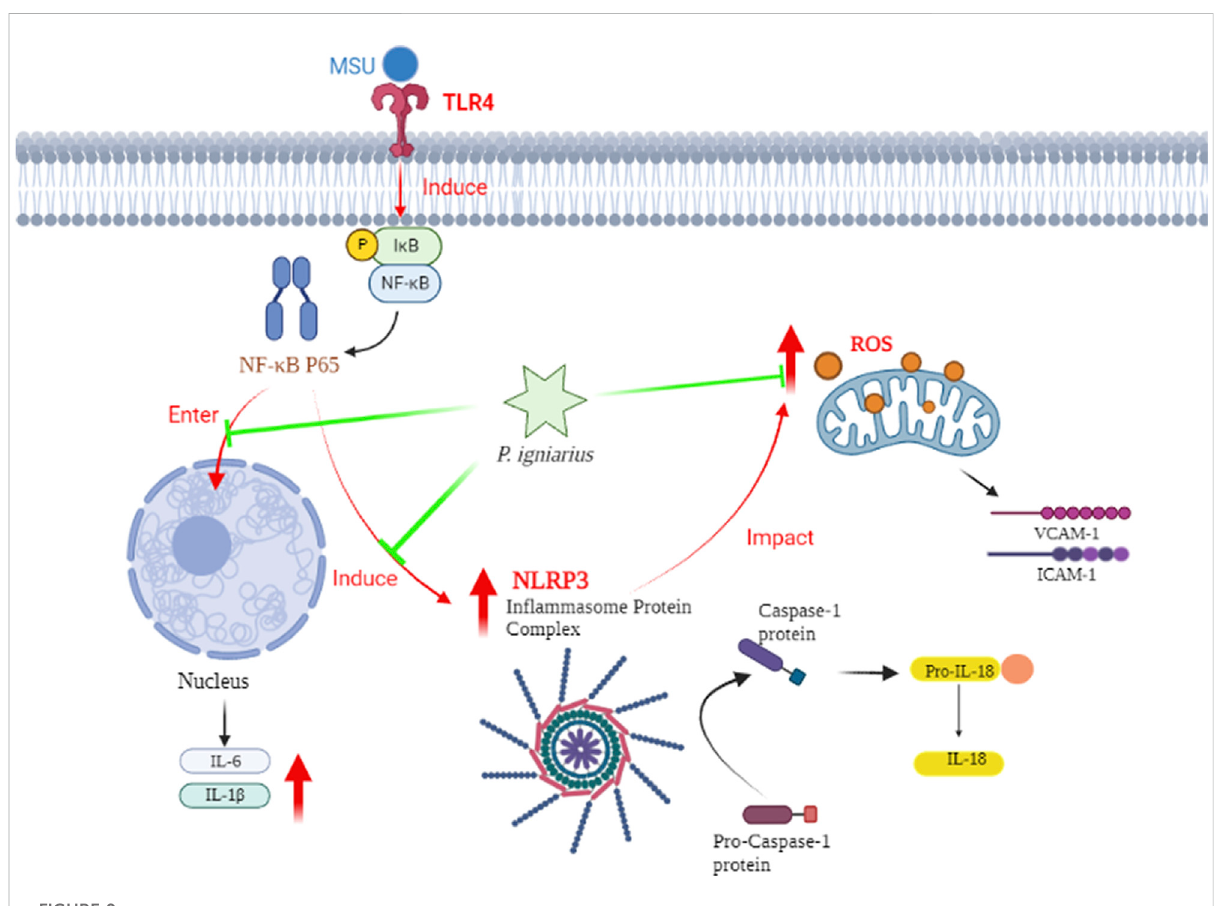
FIGURE 9 The hypothetical mechanism of P. igniarius in